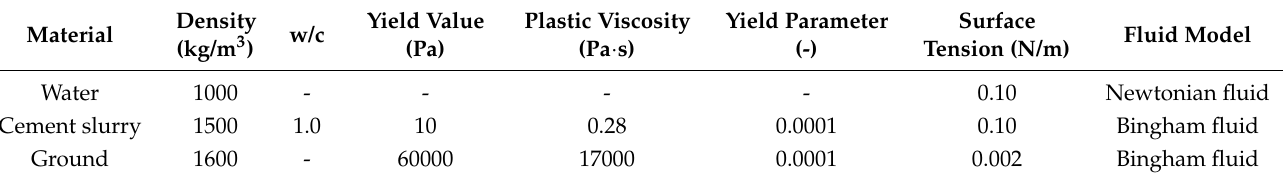
Table 2. Material